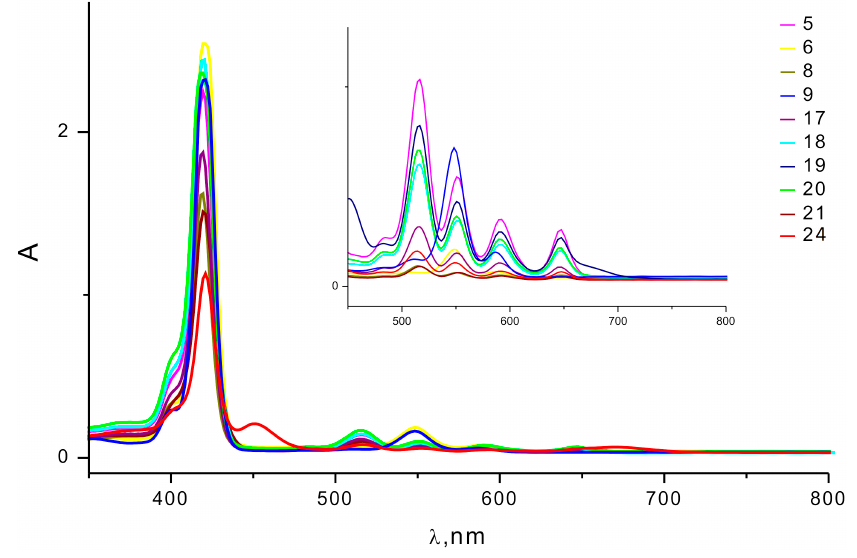
Figure 1. Absorption spectra of compounds 5 , 6 , 8 , 9 , 17 – 21 and 24 .